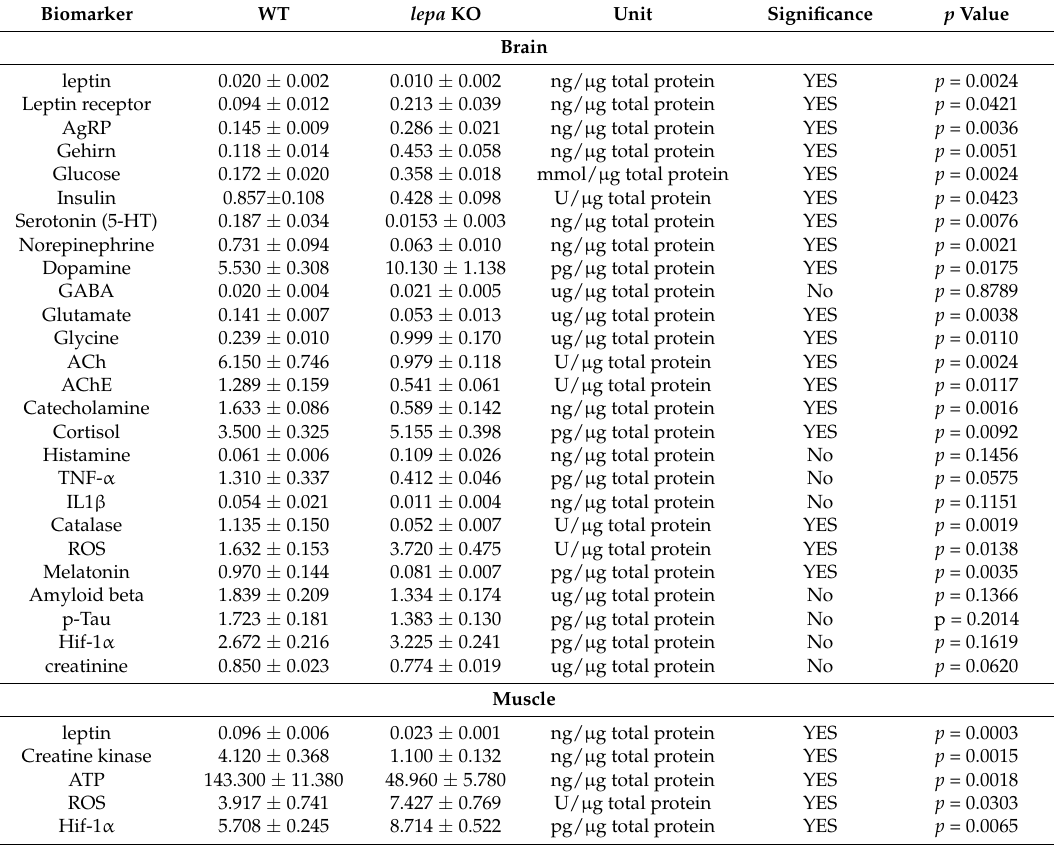
Table 1. Comparison of expression levels of biochemical markers between untreated wild type and lepa KO